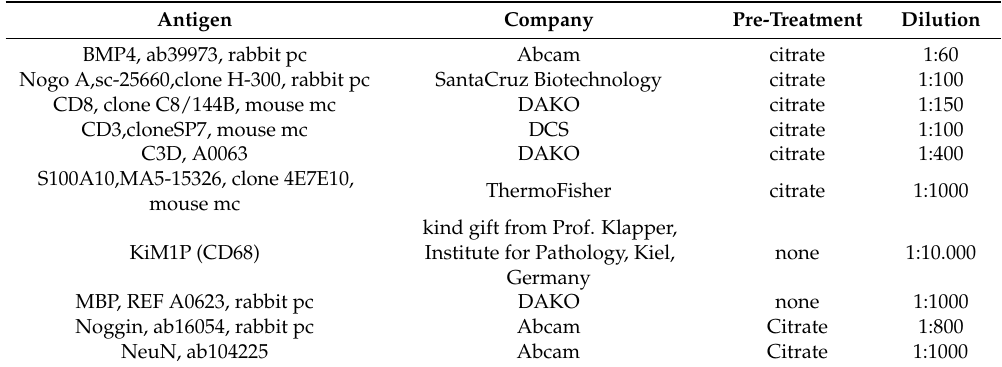
Table 2. Antibodies and staining